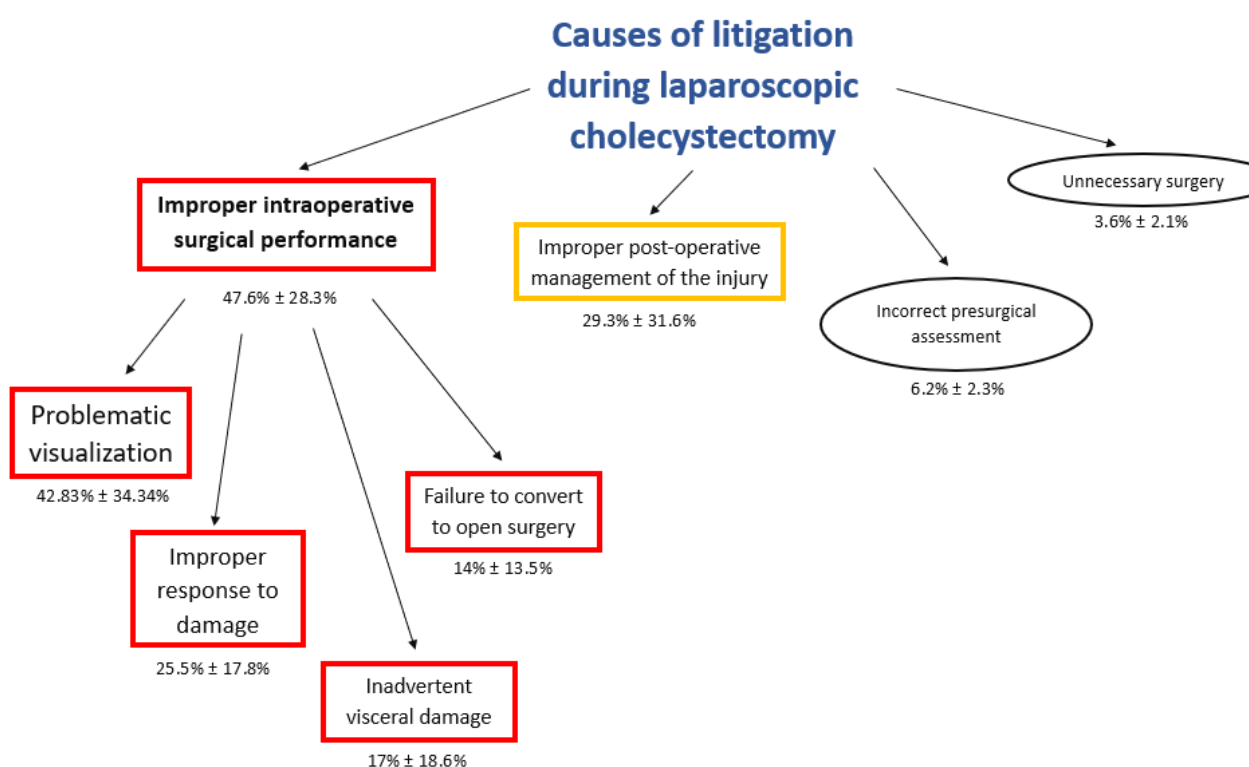
Figure 4. Flowchart of causes of litigation during laparoscopic cholecystectomy.